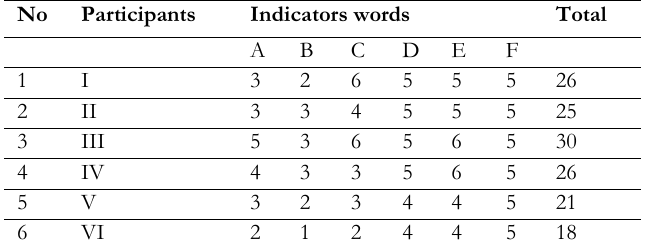
TABLE 2. The Specifications of the Test